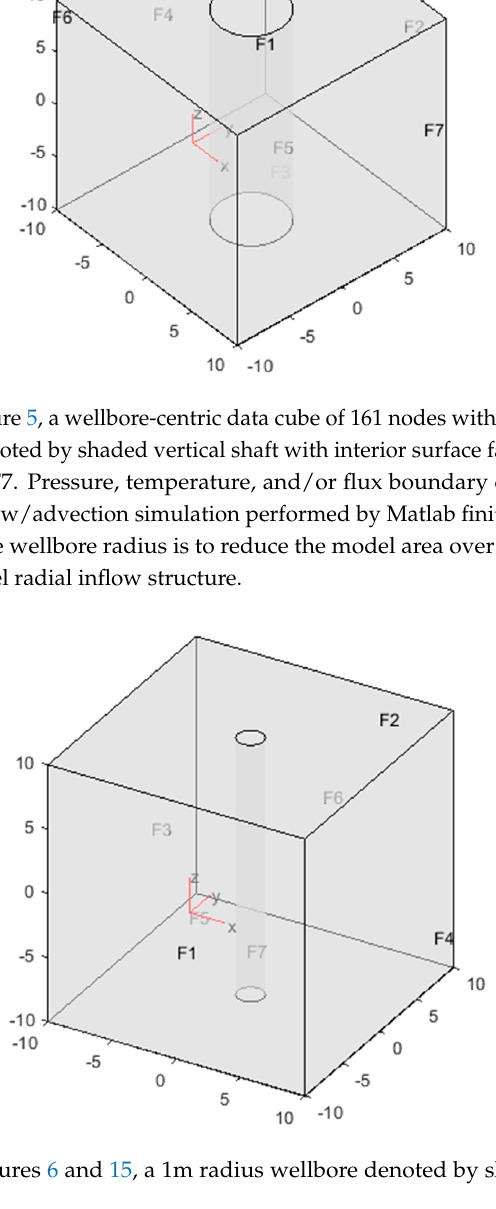
Figure 14. Following Figures 6 and 15, a 1m radius wellbore denoted by shaded vertical shaft with interior surface face F7.